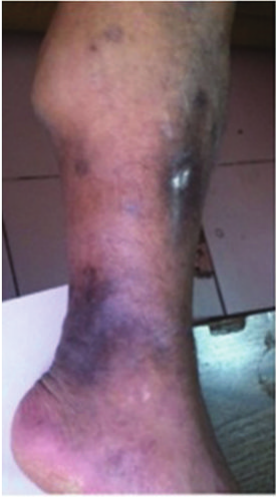
Figure 1: Hyperpigmented scars in extensor and lateral part of leg, 60 × 91 mm.